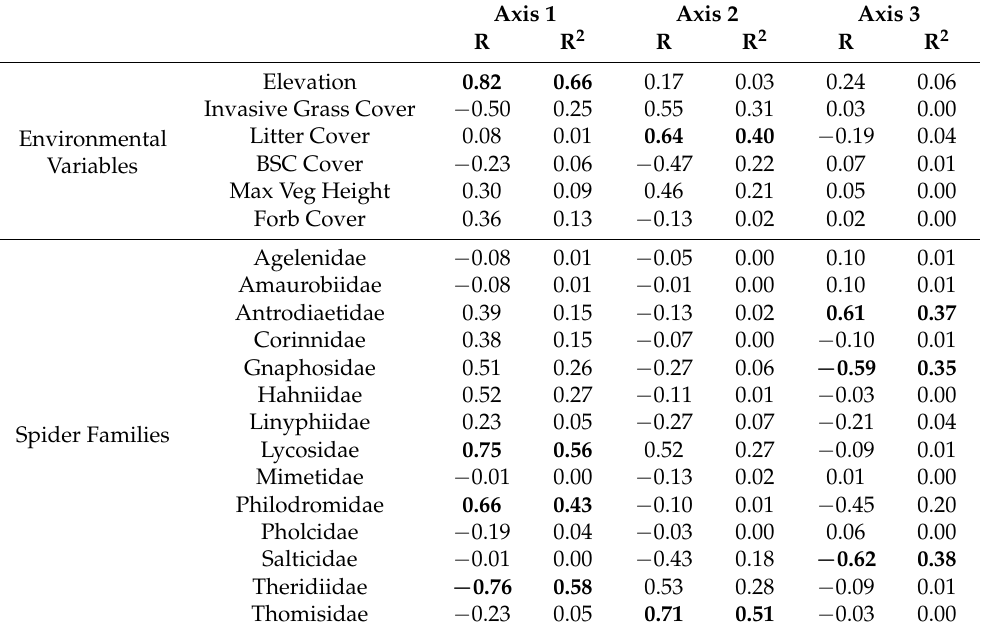
Figure 2. Non-metric multidimensional scaling ordination of sites in spider family space along with weighted average positions for spider families for axes 1 vs. 2. Each triangle represents a site and each blue circle point represents a spider family. A joint-plot from the environmental matrix is overlaid with variables of r 2 > 0.30 being displayed with vector lengths corresponding to the correlation strength along the axes (shown in thick black lines). Sites that are closer together are more similar than sites farther away from each other. Convex hulls connect each group of sites relative to location. Table 3. Pearson correlation coefficients between environmental variables and spider families and each axis of the 3-dimensional non-metric multidimensional scaling (NMS) ordination. Cells with significant correlation coefficients (r 2 > 0.35) are in